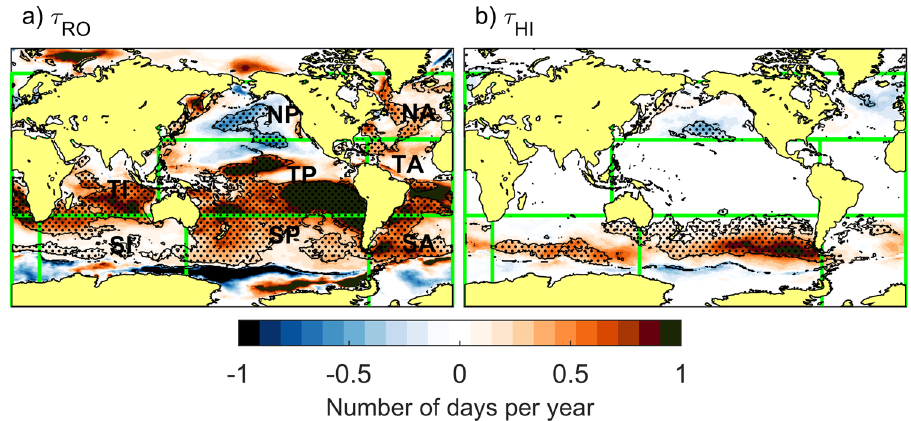
Fig. 6 Trends in the frequency of extreme wave heights based on the 7-member ensemble for 1980 – 2014. Annual number of a rough ( τ RO ) and b high ( τ HI ) wave days. Stippling indicates regions of robust trends (multi-member ensemble mean > inter-member standard deviation; (see the “ Methods ” section). See Fig. 4 for the de fi nition of large-scale ocean regions. Table 3 Ensemble mean trends (cm per year) and percent area experiencing robust signals of H s change for the JJA season. Region